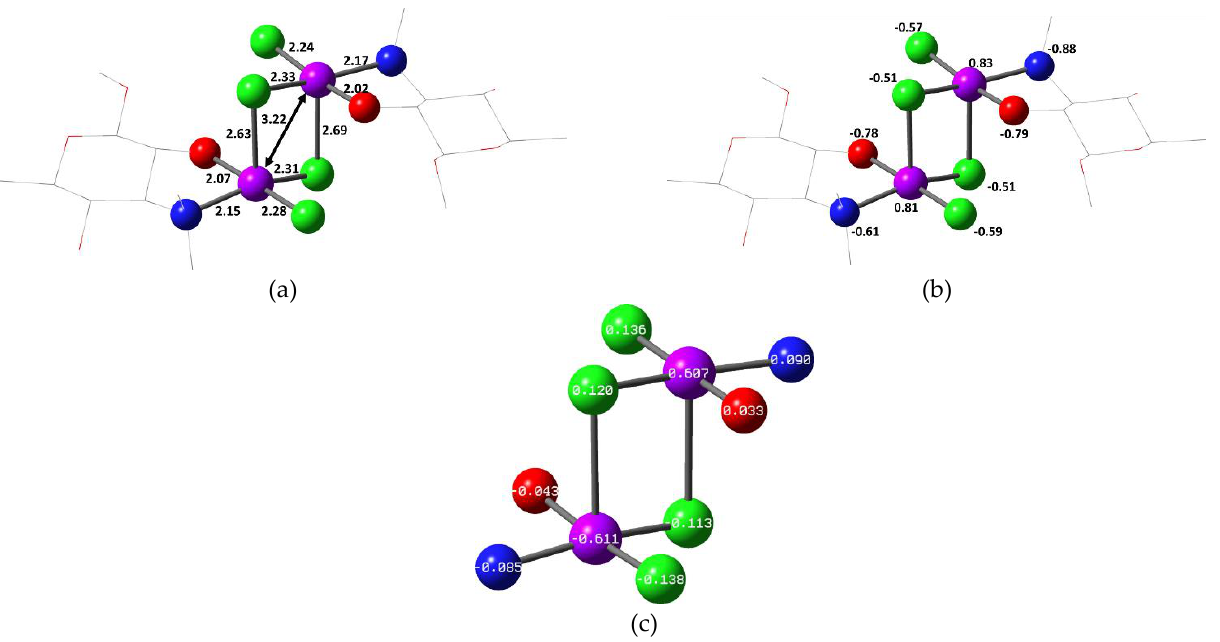
Figure 14. Optimized structure of the dinuclear green mycaminosyl complex 7 ( BHandHLYP ) with ( a ) structural parameters, ( b ) NBO charges and ( c ) spin density. Hydrogens are omitted for clarity. Colour code: C—grey, O—red, N—blue, Cl—green, Cu—magenta.